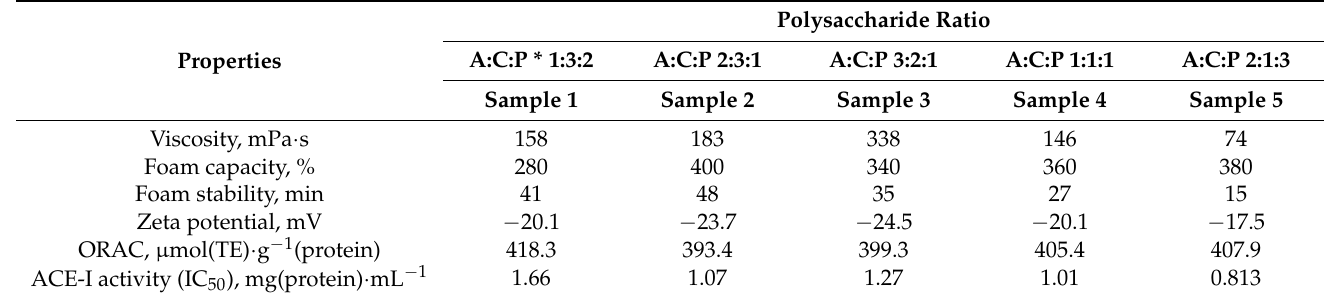
Table 1. The rheological, foam-forming and functional properties of compositions comtaining whey protein hydrolysates and plant polysaccharides